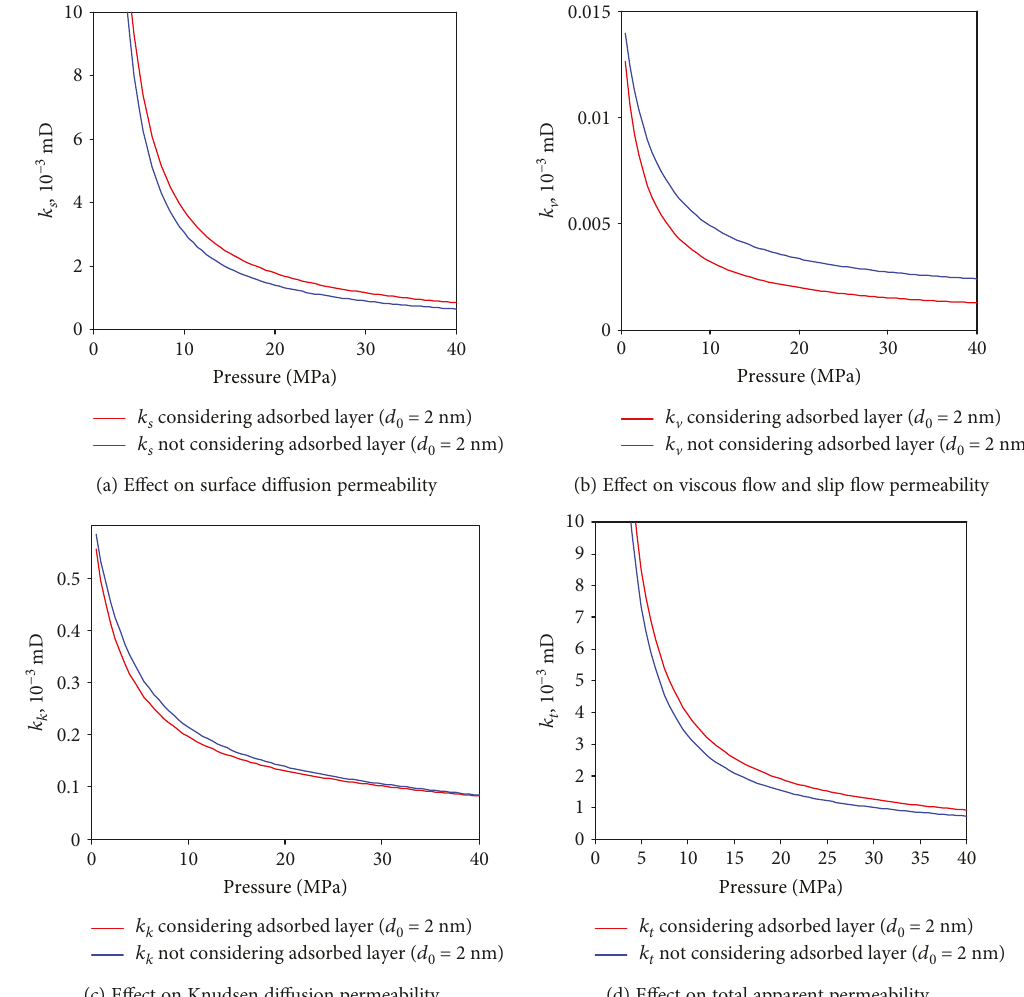
Figure 13: The e ff ect of the adsorbed layer on apparent permeability of shale (pore diameter = 2nm